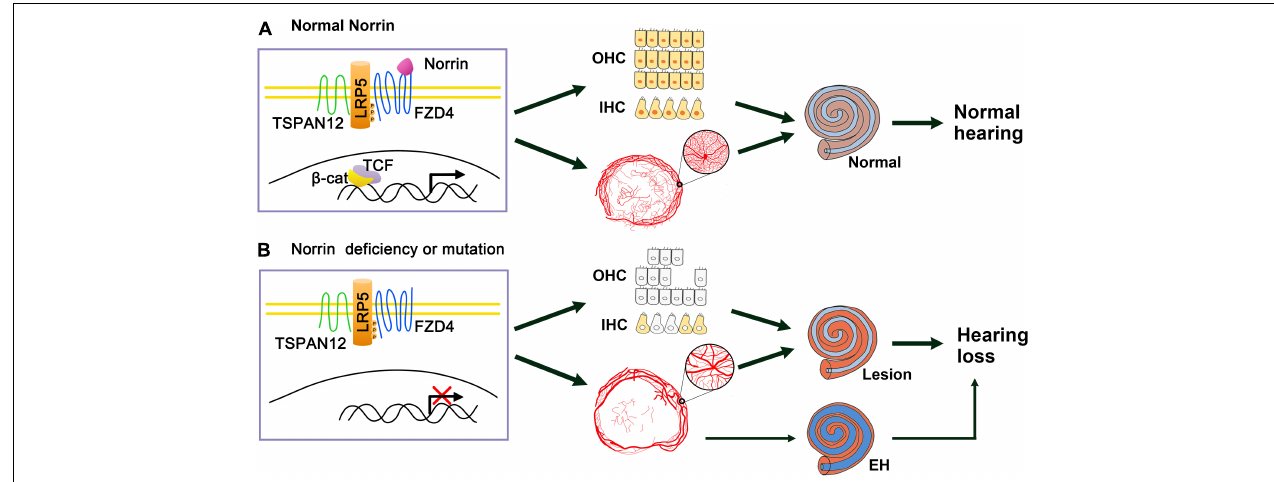
FIGURE 8 | Schematic of Norrin deficiency causes deafness of ND patients through inactivating Wnt signal pathway. (A) When normal Norrin is existence, Norrin binds to the receptor complex FZD4/LRP5/TSPAN12 and Wnt signal pathway is activated, then transcription of the target genes turns on, thus maintaining the normal HCs and producing normal vascular system of the stria vascularum and hearing. (B) When Norrin is deficiency or mutation, which leads to destruction of Norrin/FZD4/LRP5/TSP12 complex and the failure of activation of Wnt pathway, which makes the key factors (marked with yellow and orange colors) of HCs be suppressed and HCs’ loss. At the same time, it induces the abnormal vascular system of the stria vascularum and then the lesions of the inner ear directly. And abnormal vascular system of the stria vascularum also can cause EH in some cases, then leads to EH related hearing loss. At last, all these three ways developed profound hearing